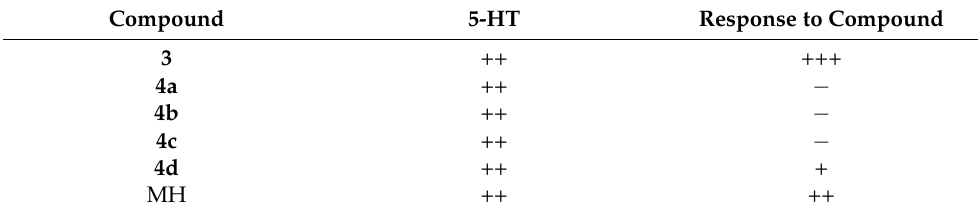
Table 6. 5-HT expression and response to compounds 3 , 4a – d compared to mebeverine hydrochlo- ride